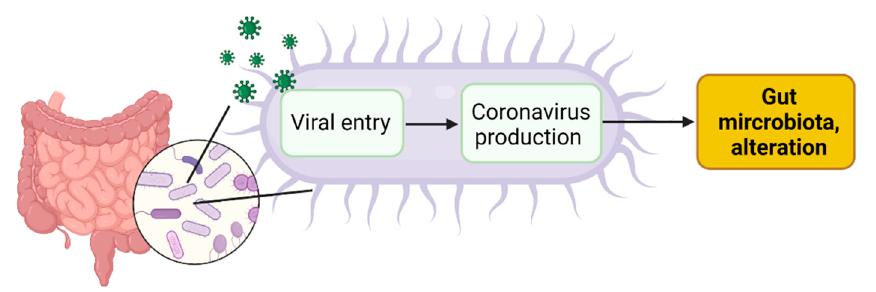
Figure 3. SARS-CoV2 infection of gut microbial bacteria might drive alteration in the gut microbiota. Created with Biorender.com.